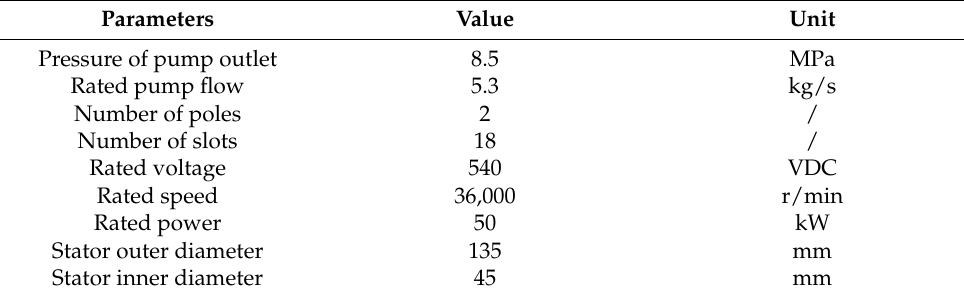
Table 3. Main parameters of electric pump structure.